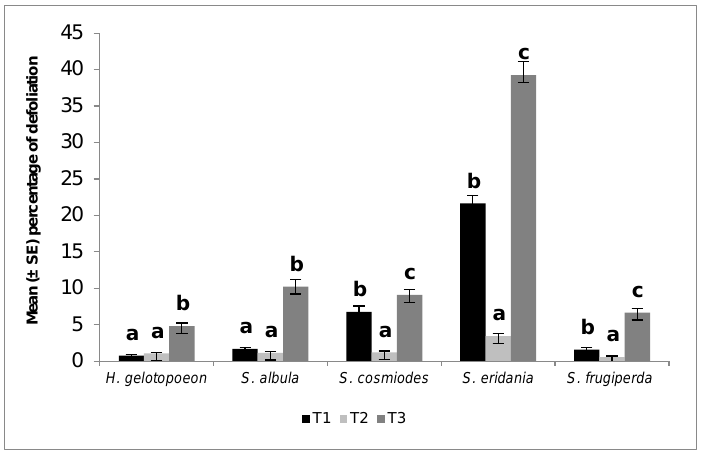
Figure 1. Percentage of defoliation produced by Helicoverpa gelotopoeon , Spodoptera albula , Spodoptera cosmiodes , Spodoptera eridania , and Spodoptera frugiperda (Lepidoptera: Noctuidae) larvae in different soybean treatments (T1: Bt soybean, T2: non-Bt soybean with seed treatment, T3: non-Bt soybean without seed treatment). Means ± SE within species accompanied by different letters indicate significant differences (Tukey test, p < 0.05).